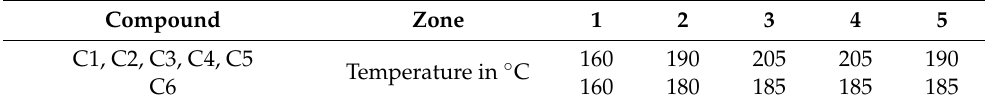
Table 3. Temperature profile during filament extrusion.